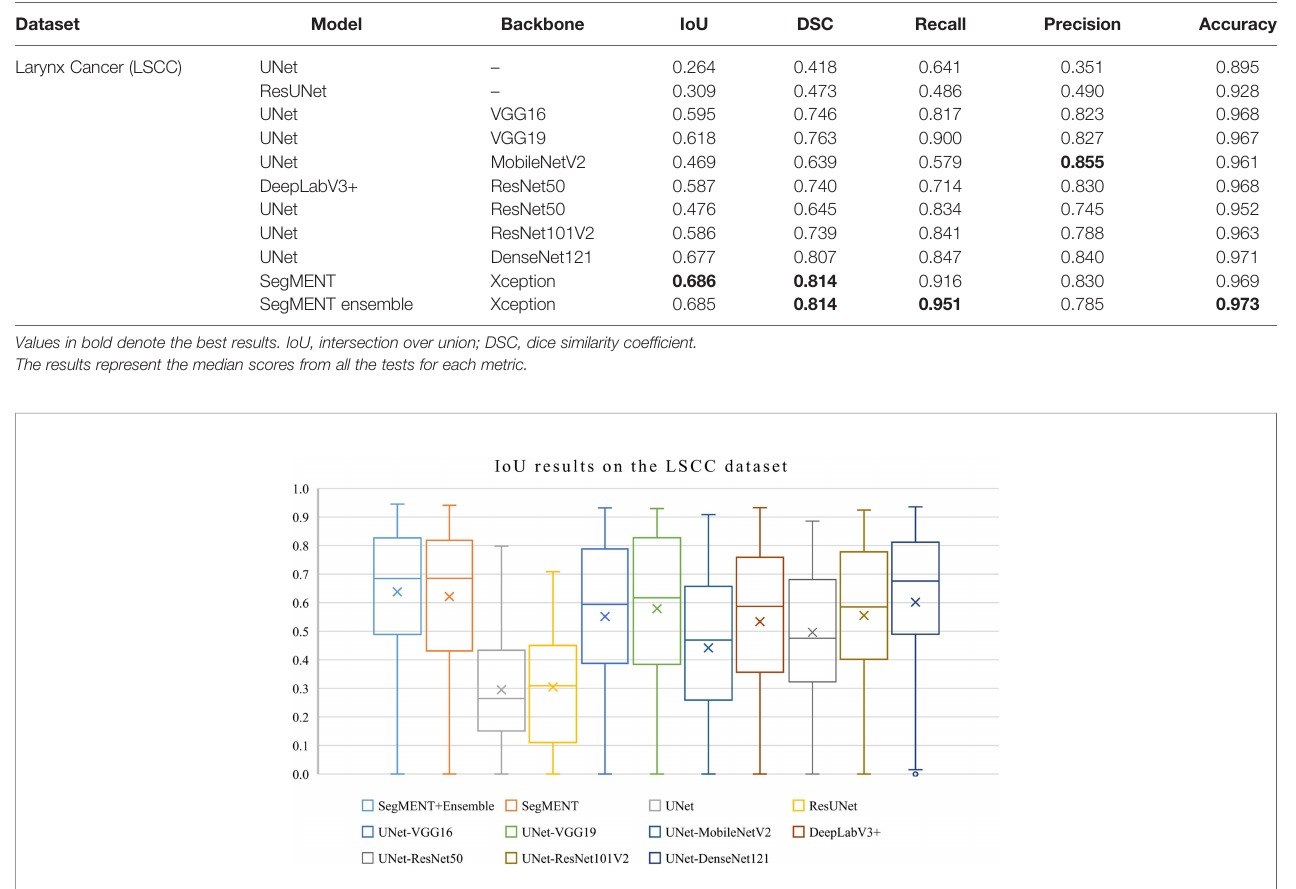
FIGURE 6 | Boxplots of Intersection over Union (IoU) results from SegMENT ensemble and the other state-of-the-art segmentation models on the laryngeal squamous cell carcinoma (LSCC) dataset. The cross sign represents the mean value while the horizontal line inside the boxplot shows the median value.